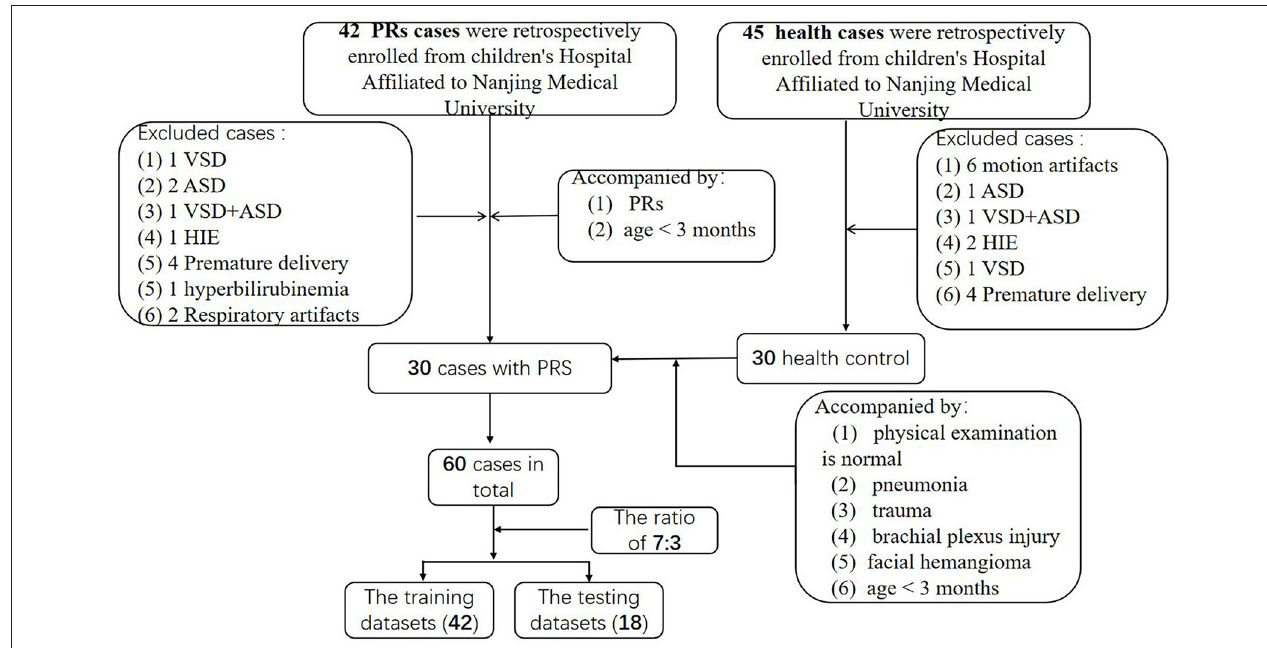
FIGURE 1 | Flow diagram of enrolled patients. HIE, neonatal hypoxic-ischemic encephalopathy; VSD, ventricular septal defect; ASD, atrial septal